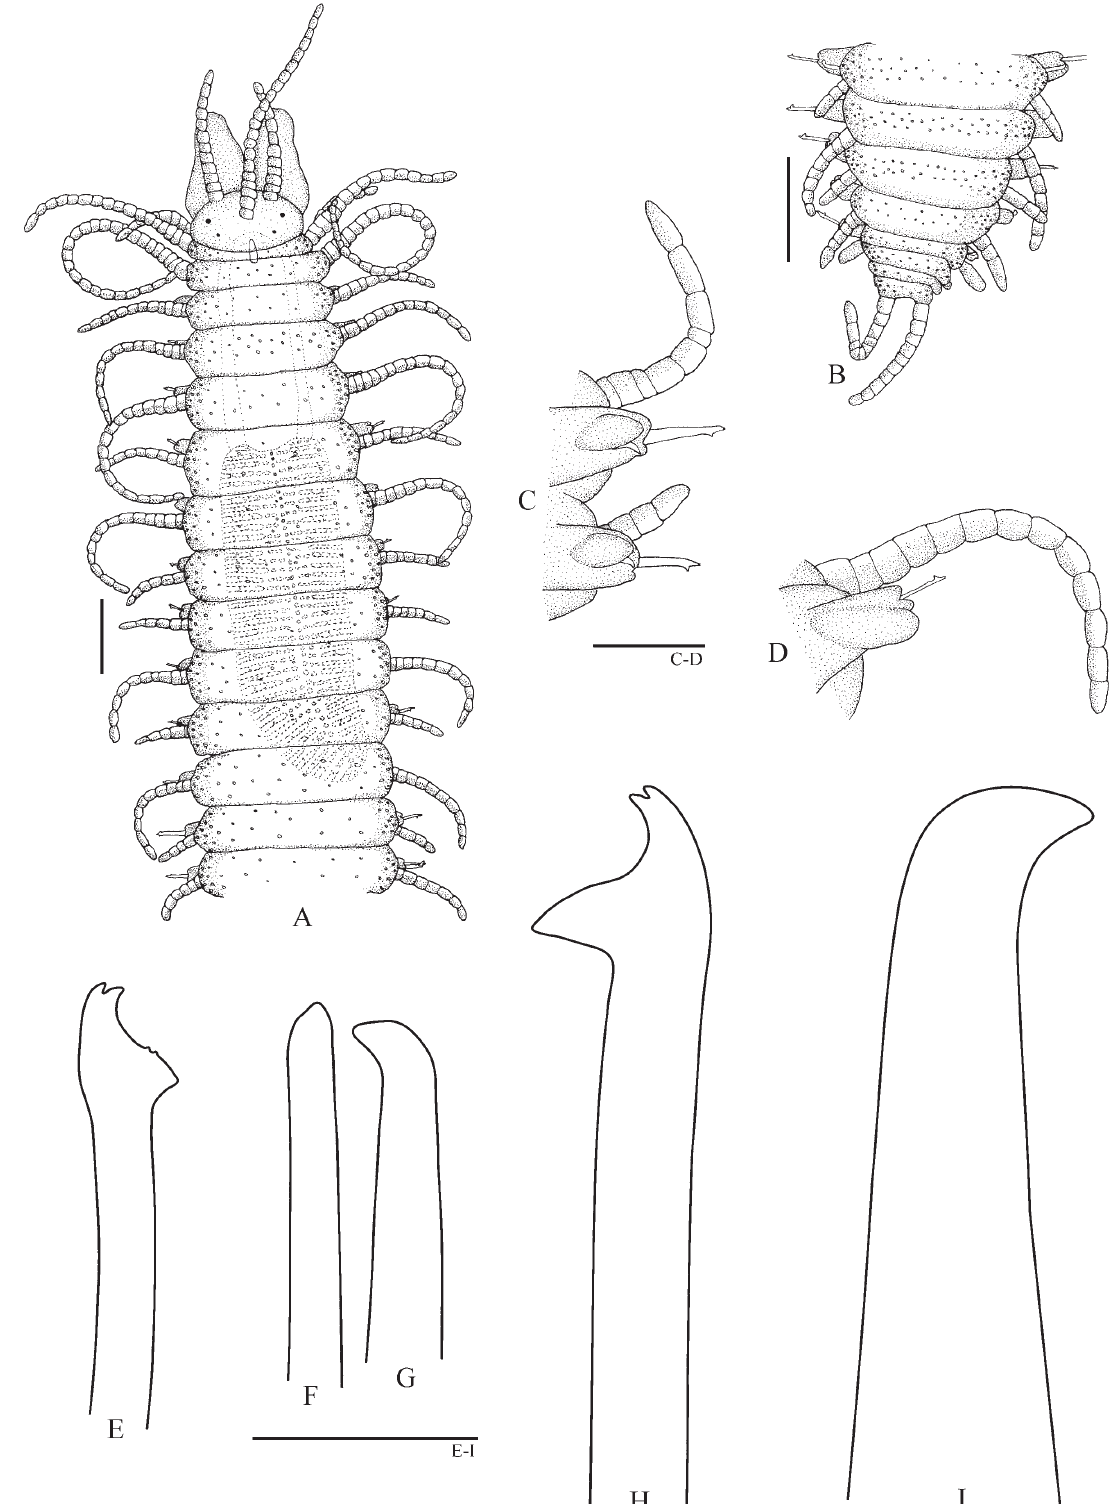
Fig . 15. – Hand-drawing of Haplosyllis niphatesicola n. sp. A, anterior end, dorsal view. B, posterior end, dorsal view. C, mid-body parapodia, five post-proventricular segments. D-G: Chaetiger 3. D, parapodium. E, chaeta. F, straight acicula. G, acicula with curved tip. H-I: Chaetiger 13. H, mid-body chaeta. I, mid-body acicula. Scale bars: A-B (200 m m), C-D (100 m m), E-I (20 m m). INV-ANE